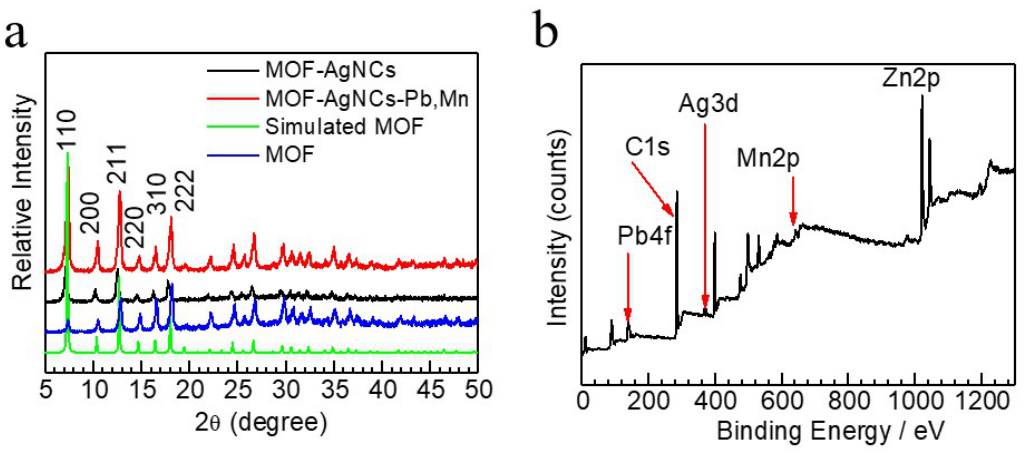
Figure 6. XRD patterns of ZIF-8, MOF-AgNCs and the product for the treatment of Mn 2+ and Pb 2+ ( a ); XPS survey of the product for removal of Mn 2+ and Pb 2+ ( b ).